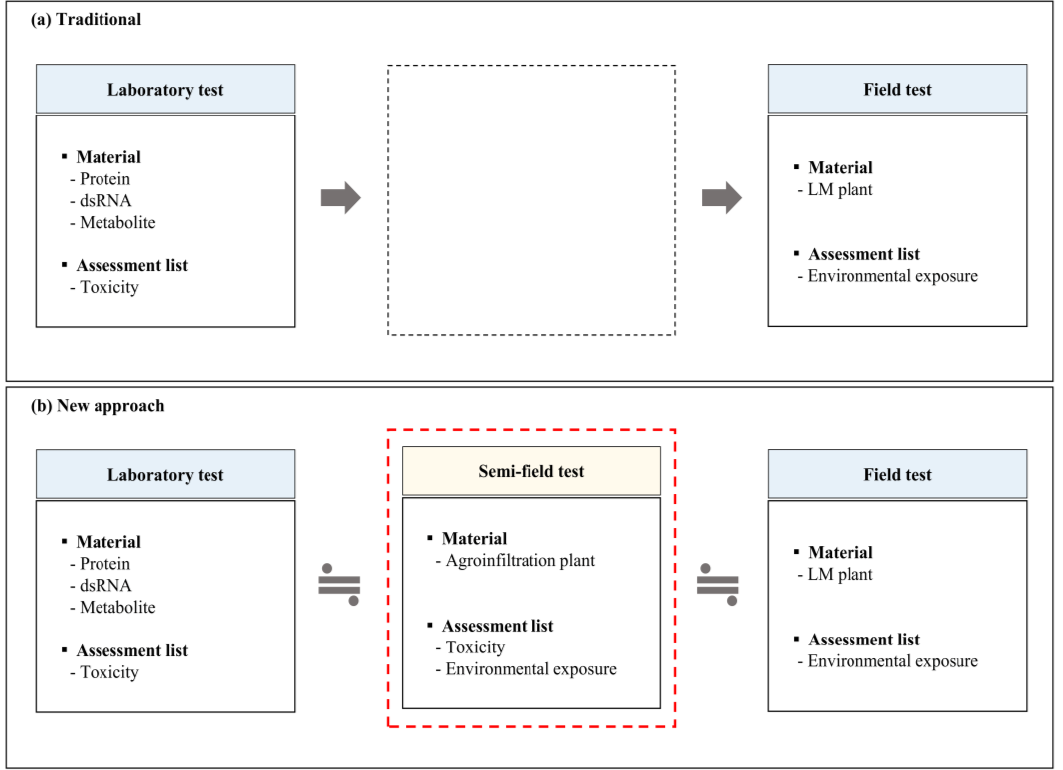
Figure 2. Scheme of the new risk assessment strategy. ( a ) Traditional risk assessment methods include laboratory and field trials. ( b ) A new risk assessment approach based on transient expression models of plants using an agroinfiltration method.